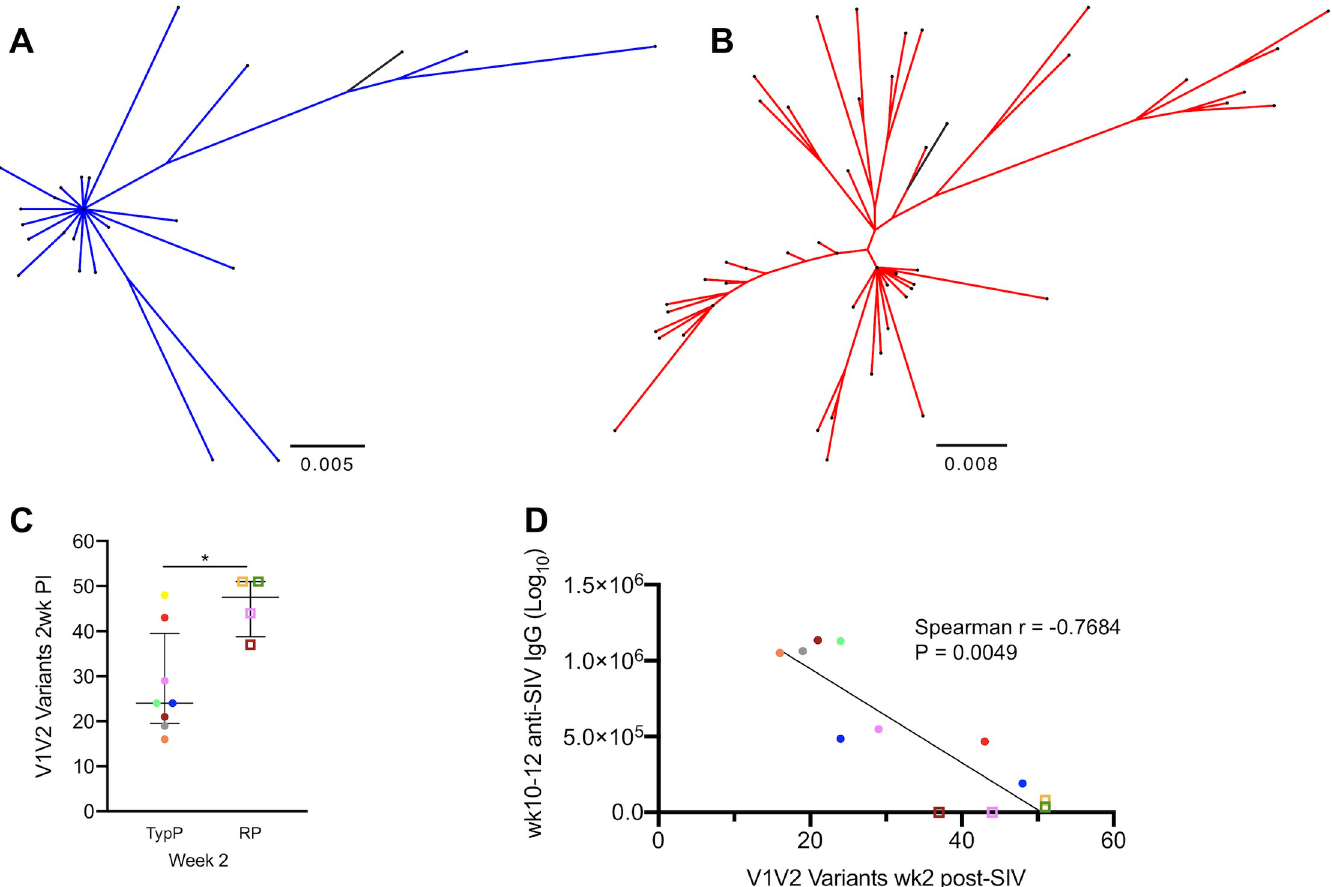
Fig 2. Number of unique plasma viral variants detected at week 2 post infection negatively correlates with anti-SIV antibodies at wk10. SIV viral variants were assessed at 2 weeks post-infection from plasma viral RNA on an Illumina MiSeq platform. Representative phylogenies are shown for TypP ( A ) and RP ( B ) infants. The total number of unique plasma viral variants was quantified and compared between TypP ( closed circles ) and RP ( open squares ) infants ( C ). Number of viral variants were compared against plasma anti-SIVenv IgG concentration ( D ). Phylogenies were constructed using maximum likelihood with a GTR substitution model. Black lines in trees represent challenge stock consensus sequence. Statistical tests used to compare infant groups were carried out as described in the methods � = p < 0.05. Error bars are shown as either mean with standard deviation or median with interquartile range based on data distribution.